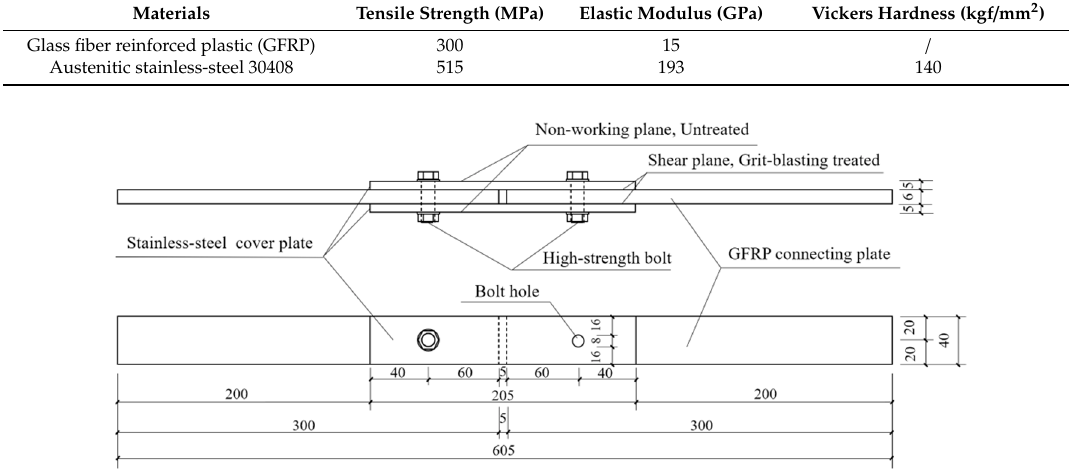
Table 1. Mechanical properties of plates.